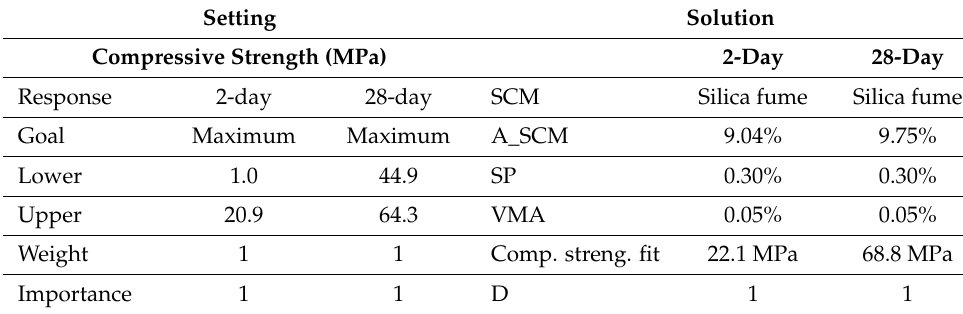
Figure 7. Main effects plot for 28-day compressive strength. Table 10. Optimized results for 2-day and 28-day compressive strength.